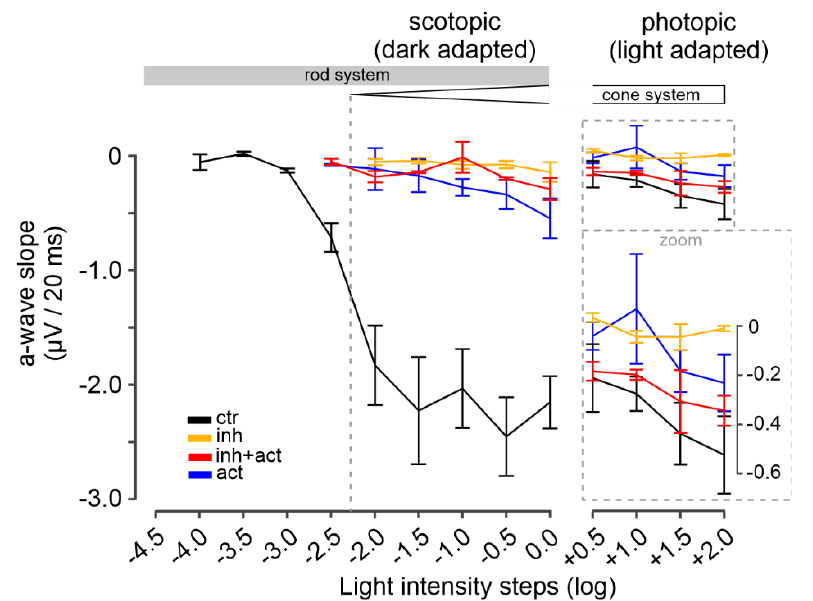
Figure 7. Modulation of photoreceptor-response kinetics by cGMP analogues. Illustration of the a-wave slope calculated as a-wave amplitude deflection in µV per 20 ms. Scotopic (dark-adapted, rod function) light conditions shown in left panel, photopic (light-adapted, cone function) light conditions in right panel. Experimental conditions: control (black), inhibitor (Rp-8-Br-PET-cGMPS, 50 µM, orange), activator (8-pCPT-cGMP, 0.1 µM, blue) and inhibitor-and-activator co-application (red, 50 µM and 0.1 µM, respectively). n = 5 retinae for each condition. Data shown are averages of 30 MEA recording electrodes, per condition. See Figures S3 and S4 for the respective µERG trace and spike data, and Tables S4 and S5 for all values and statistical evaluation.